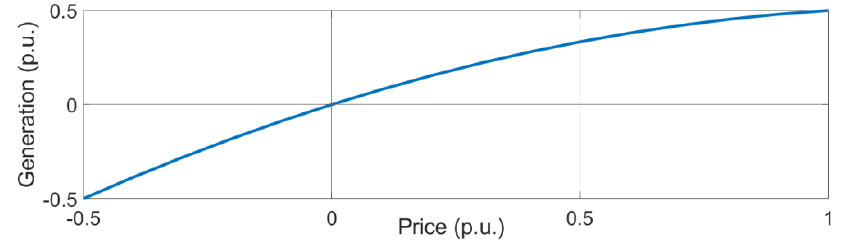
Figure 2. Steady-state power generation vs. electricity price.